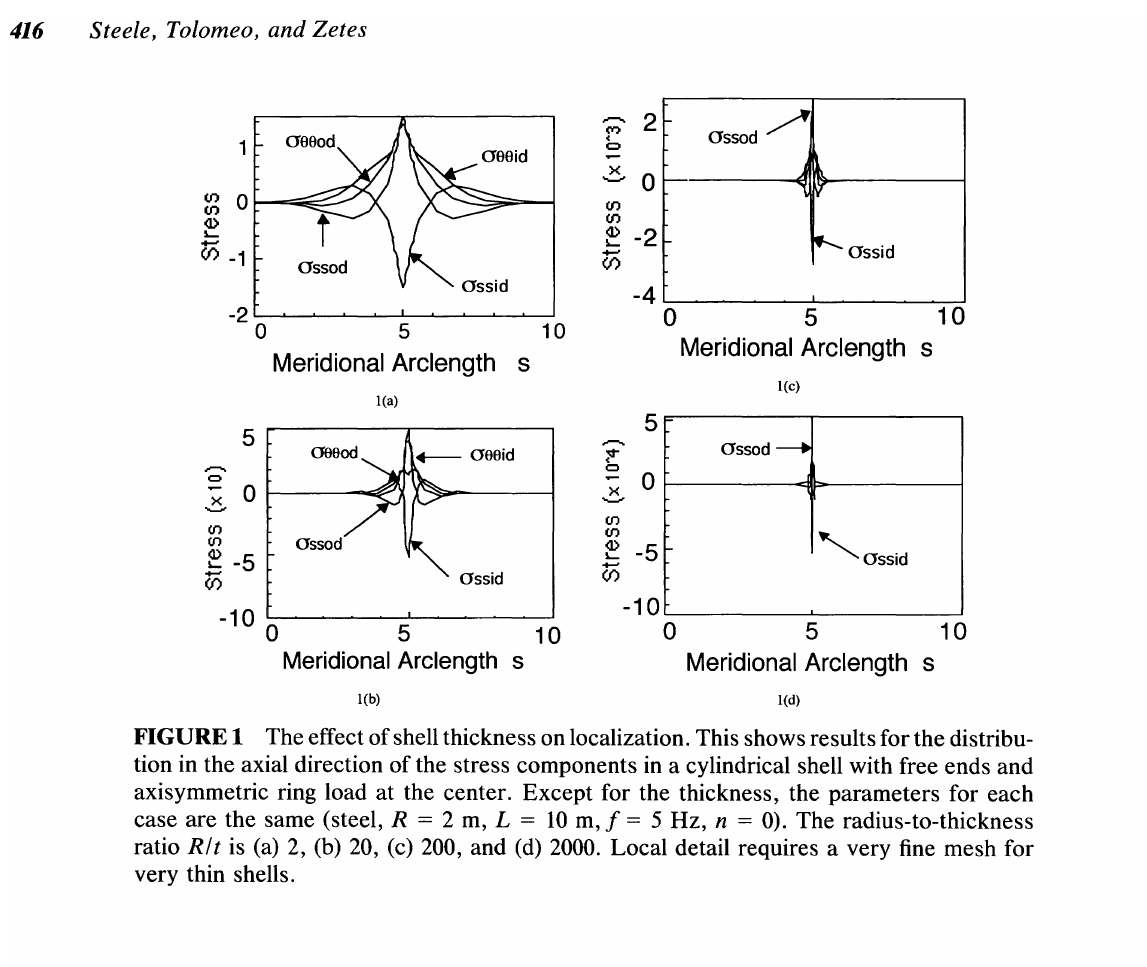
FIGURE 1 The effect of shell thickness on localization. This shows results for the distribu tion in the axial direction of the stress components in a cylindrical shell with free ends and axisymmetric ring load at the center. Except for the thickness, the parameters for each case are the same (steel, R = 2 m, L = 10 m, f = 5 Hz, n = 0). The radius-to-thickness ratio Rtt is (a) 2, (b) 20, (c) 200, and (d) 2000. Local detail requires a very fine mesh for very thin